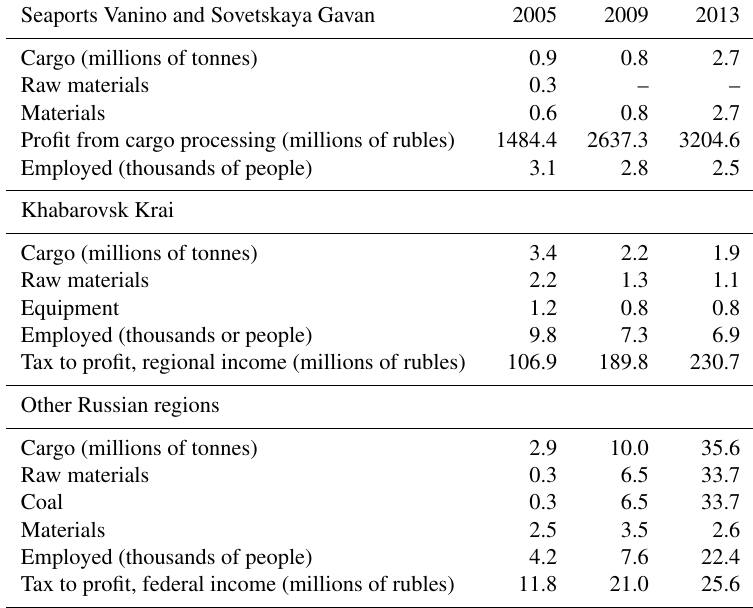
Table 1. Current state of seaports Vanino and Sovetskaya Gavan as beneficiaries to themselves, to Khabarovsk Krai and to the Russian Federation